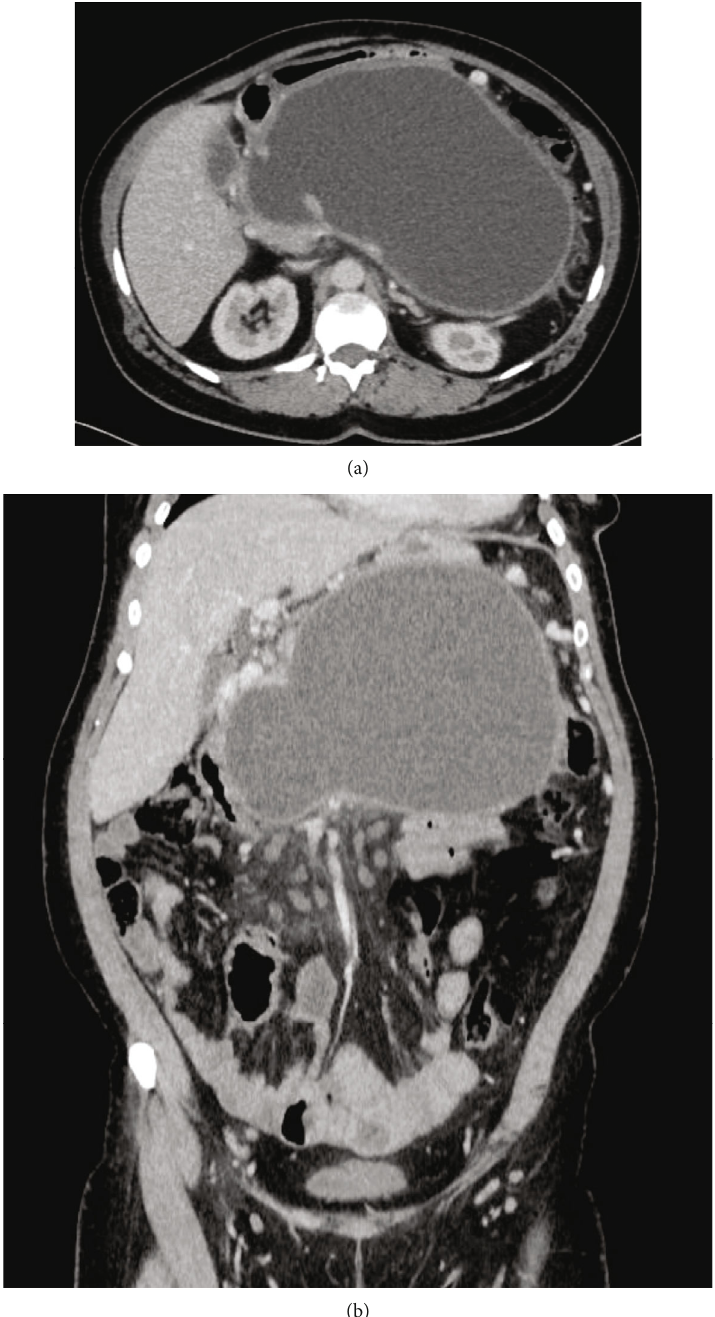
Figure 1: (a, b) A large pancreatic pseudocyst visualized by abdominal CECT in a female patient with acute